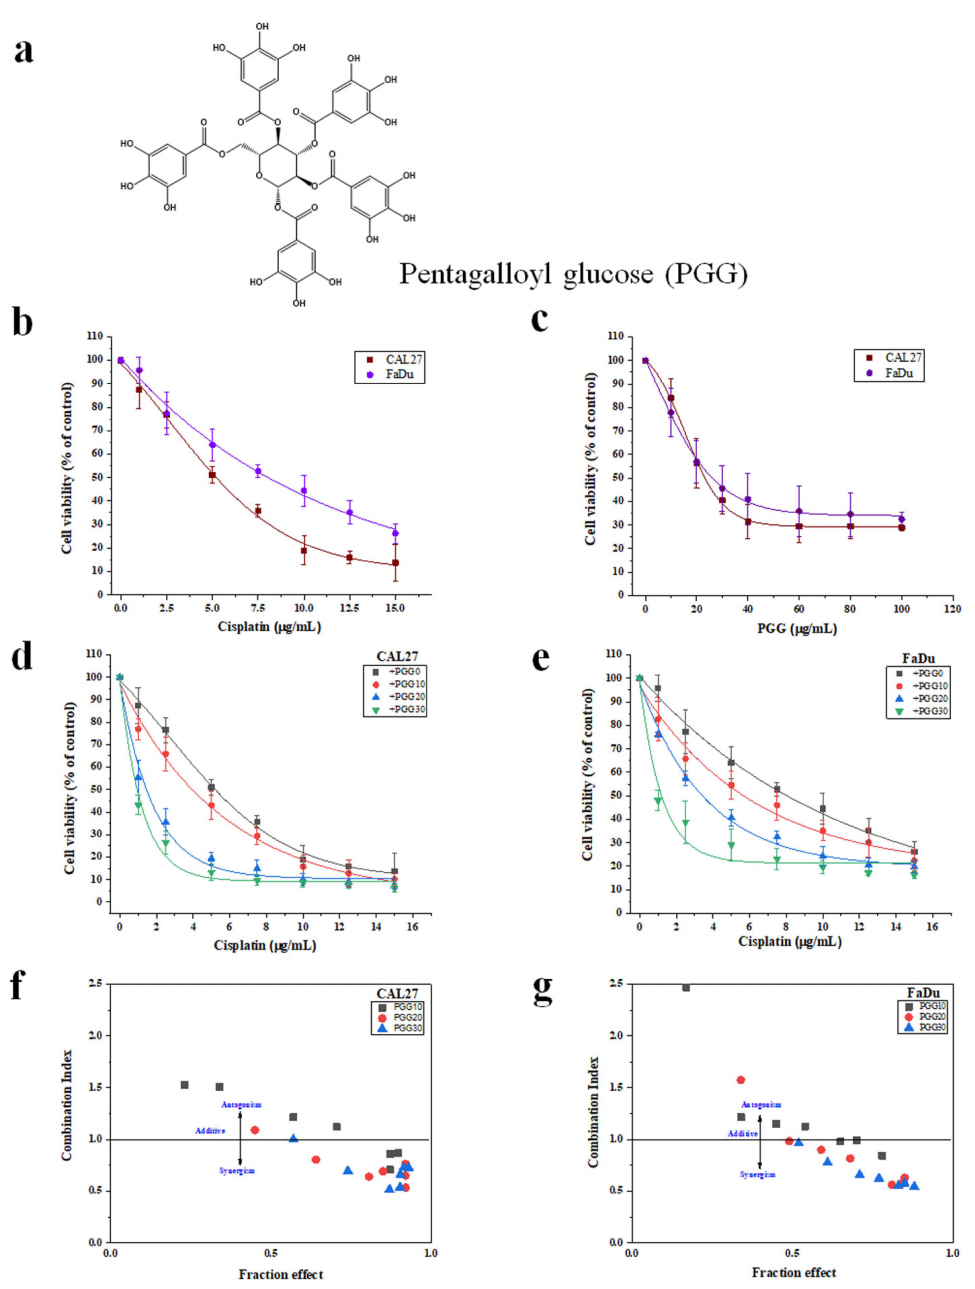
Figure 1. The cell proliferation inhibitory effect of PGG and cisplatin in monotherapy and in combi- nation on HNSCC cancer cells in the 2D culture determined by the MTT assay. ( a ) Chemical structure of pentagalloyl glucose (PGG). ( b , c ) A dose–response curve of the cytotoxic effect of cisplatin ( b ) and PGG ( c ) alone on CAL27 and FaDu cell viability after 48 h treatment. ( d , e ) Effect of the combination therapy of 10, 20, and 30 µ g/mL PGG and serial concentrations of cisplatin on CAL27 ( d ) and FaDu ( e ) cell viability after 48 h treatment, determined by MTT assay. ( f , g ) Fa-CI plot analysis of the combination treatment of 10, 20, and 30 µ g/mL PGG and cisplatin on CAL27 and FaDu cell viability. PGG, pentagalloyl glucose; Fa, fraction effect; CI, combination